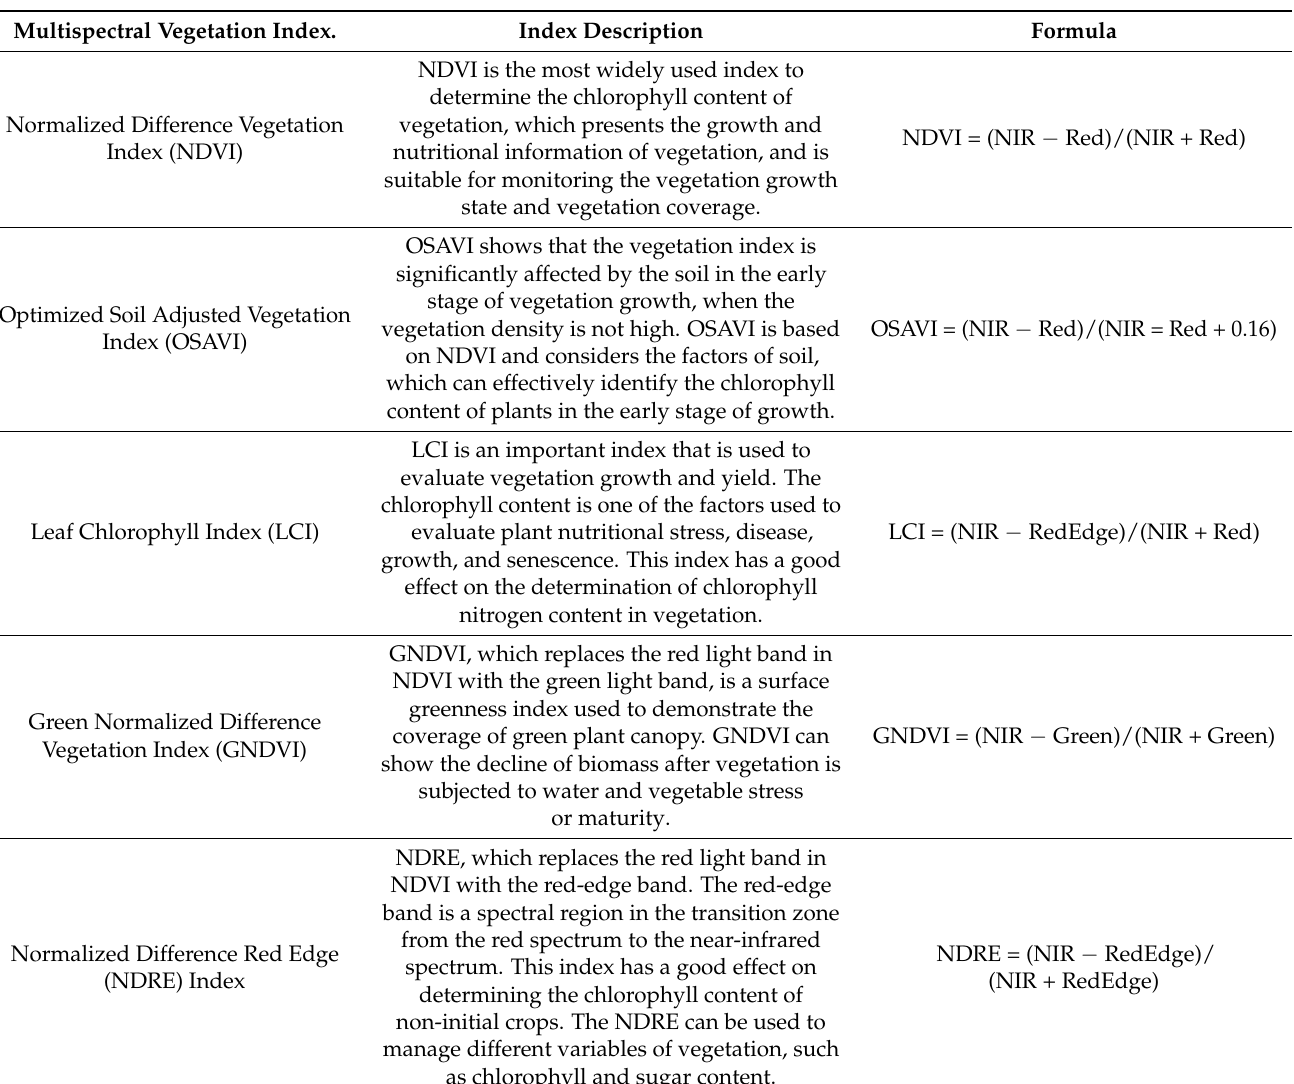
Table 1. Multispectral vegetation index